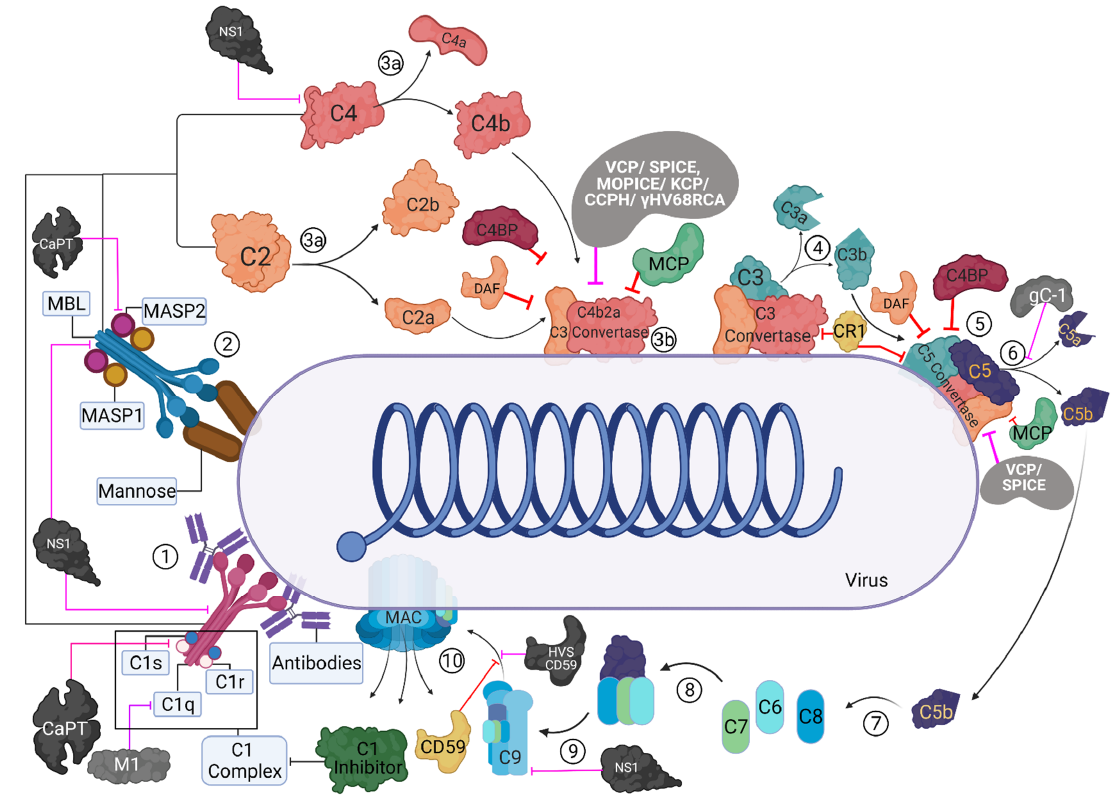
Figure 1. Activation and regulation of the classical and lectin pathways and their targeting by virally encoded molecules. In the classical pathway (CP), C1 complex recognizes the antigen-antibody complexes present on the viral surface (1). In the lectin pathway (LP), MBL/ficolin-MASP complexes can recognise other carbohydrate patterns on the surfaces of viruses (2). Upon activation, these complexes can cleave C4 and C2 (3a) that can lead to the formation of C4bC2a (CP/LP C3 convertase) (3b). The C3 convertase further cleaves C3 into C3b and C3a; C3b is known to opsonise the viral surfaces, whereas C3a can lead to an enhanced acquired immune responses (4). C3b-C3 convertase interaction can generate C5 convertase (5), which cleaves C5 into C5b and C5a (6). C5b further interacts with C6 and C7 (C5b-7) (7) that can bind to the viral surface, while C5a induces further infiltration. C5b-7 then binds to C8, which can generate C5b-8 that penetrates the membrane (8). Finally, the C9 binds to the C5b-8 and results in MAC formation leading to the virolysis (10). These activation pathways are regulated at different steps by host complement regulators such as C1 inhibitor, C4b-binding protein (C4BP), complement receptor 1 (CR1; CD35), membrane cofactor protein (MCP; CD46), decay-accelerating factor (DAF; CD55), and CD59. Viral proteins that target these pathways are: Vaccinia virus complement control protein (VCP), Smallpox inhibitor of complement enzymes (SPICE), Monkeypox inhibitor of complement enzymes (MOPICE), Kaposi’s sarcoma-associated herpesvirus inhibitor of complement activation (KCP), Murine gamma-herpesvirus 68 regulator of complement activation ( γ -HV68 RCA), Herpesvirus saimiri complement control protein homologue (CCPH), Herpesvirus saimiri CD59 homologue (HVS CD59), Flavivirus non-structural protein 1 (NS1), HSV-1 glycoprotein C (gC-1), human astrovirus coat protein (CoPt), and Influenza virus matrix protein 1 (M1). These are identified as black/grey protein with white text, and pink inhibitory arrows mark the regulator they